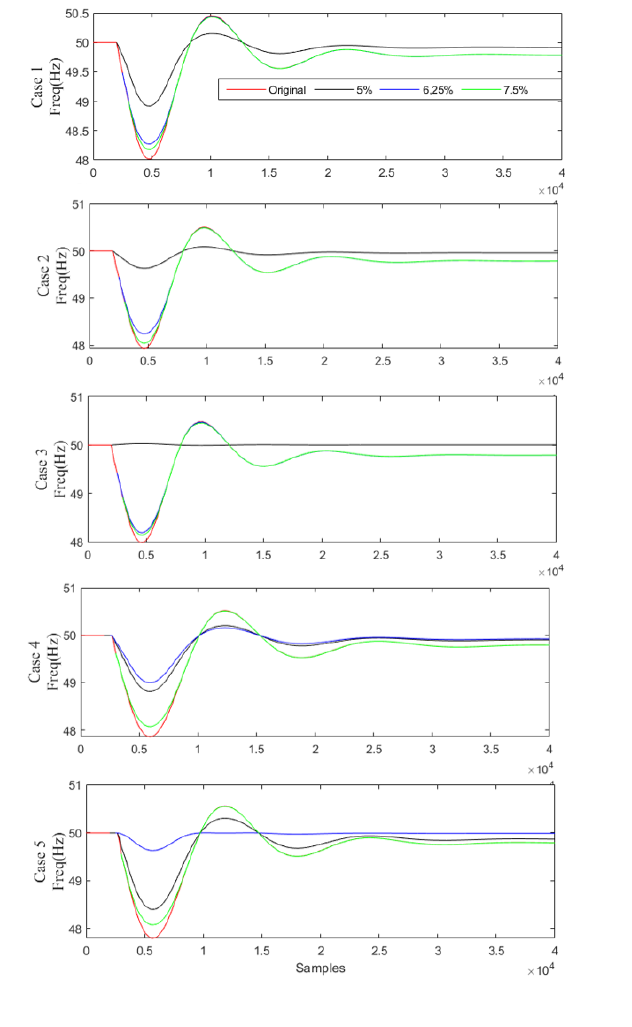
Figure 9. Results for the LSTM models in all simulation cases.